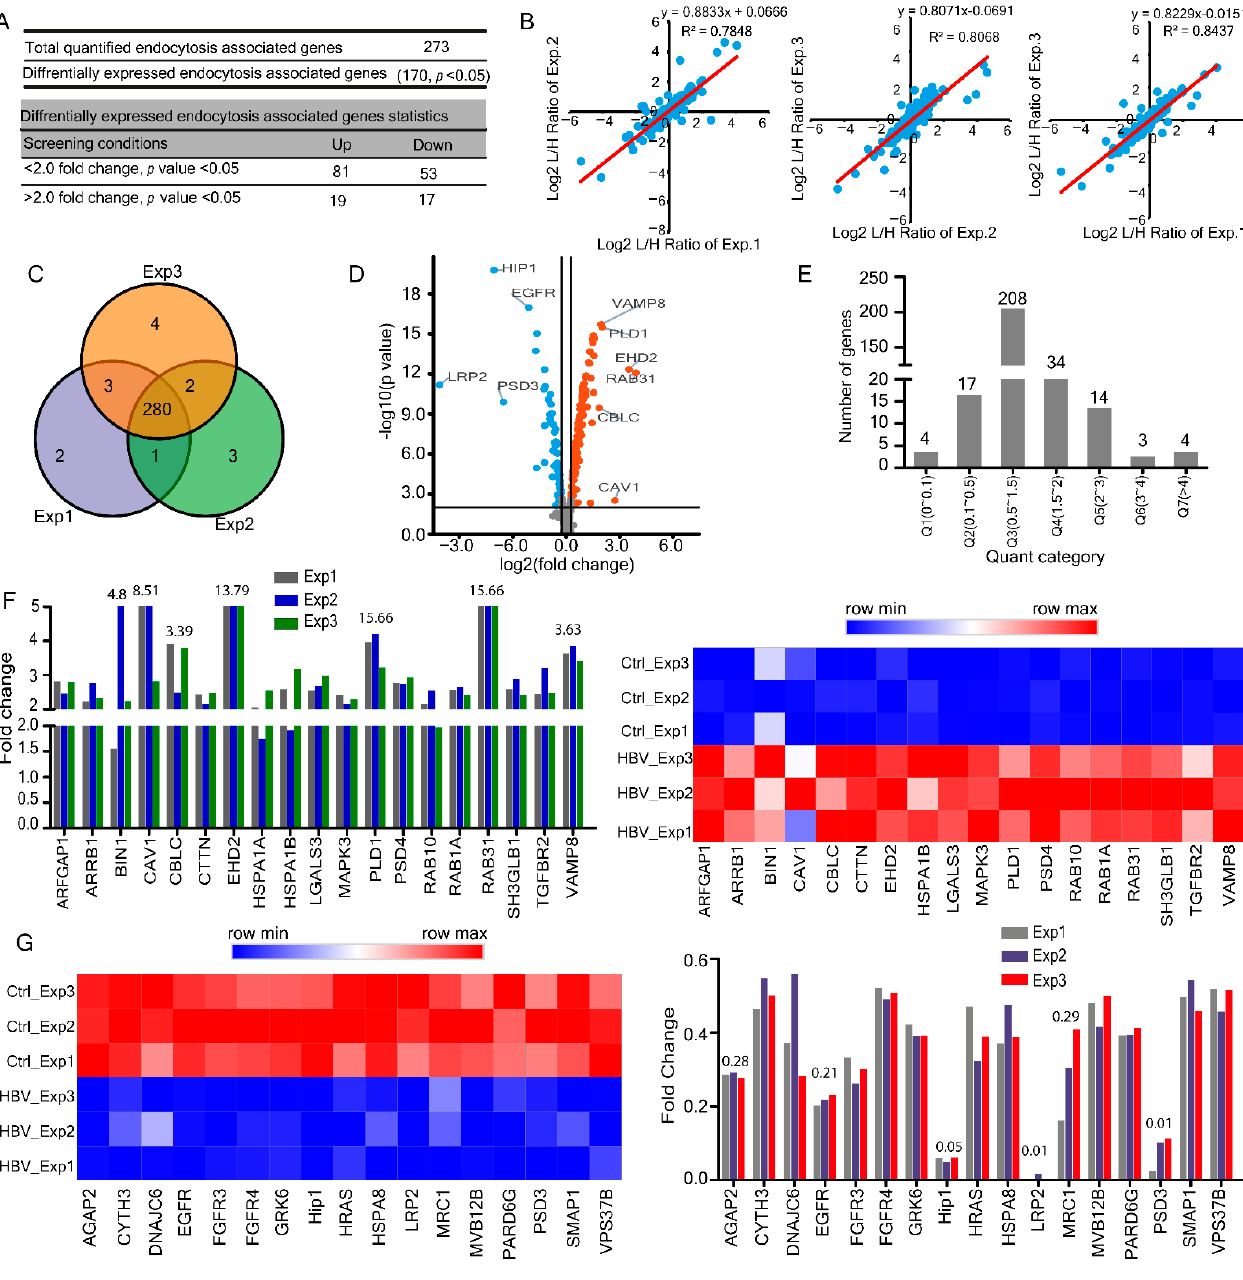
Figure 1 . HBV integration modifies host endocytosis-associated transcriptome in HepG2.2.15 cells. ( A ) Summary of quantified and differentially expressed transcriptome. ( B ) Pearson’s correlation (R 2 ) plots for three representative experiments from HepG2.2.15 cells. ( C ) Venn diagrams for three representative transcriptome experiments in HepG2.2.15, gene numbers are indicated. ( D ) The identified endocytosis-associated DEGs are shown in a volcano plot. ( E ) Distribution of regulated genes quantile results. ( F ) Two-fold up-regulated genes from three biological replicates in HepG2.2.15 cells along with heatmap representation. ( G ) Two folds down-regulated genes from three biological replicates in HepG2.2.15 cells, along with heatmap representation.